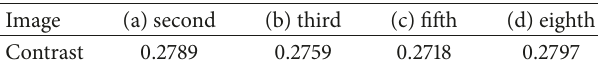
Table 2: Contrast of aluminum and silicon in the reconstructed images from Figure 3.